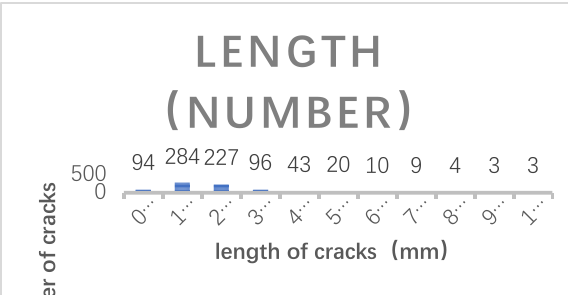
Figure 11. The number of the cracks’